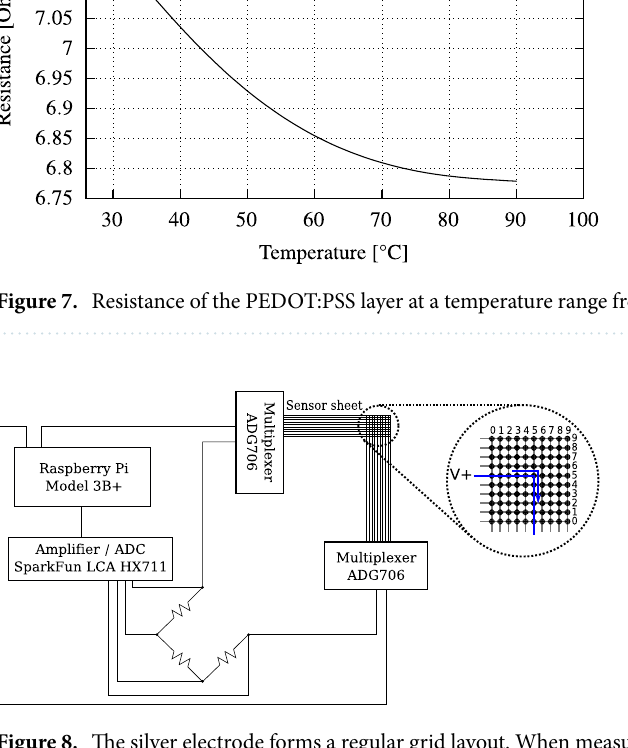
Figure 8. The silver electrode forms a regular grid layout. When measuring a specific point on the sensor sheet, a voltage is applied to a given row and ground is connected to the corresponding column, allowing a current to flow. The PEDOT:PSS layer causes a temperature dependant voltage drop which can be used to reconstruct the temperature at this